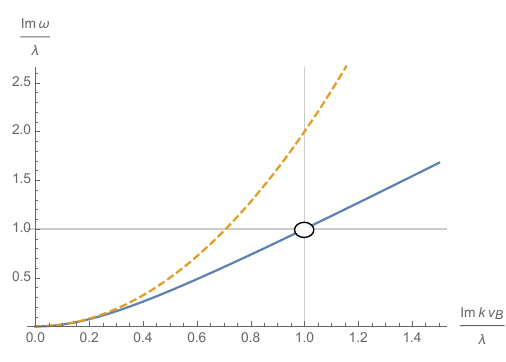
Figure 8 . The hydrodynamic origin of chaos predicts \pole-skipping" in the energy-energy correla- tion function: following the line of poles which starts at small !; k as the energy di(cid:11)usion pole along pure imaginary k to a speci(cid:12)c value of k = i(cid:21)=v B for which the pole would be at ! = i(cid:21) , one (cid:12)nds the pole is not there! In the (cid:12)gure the solid line denotes the line of poles, and the open dot indicates that at that particular point the pole is skipped. The dashed line is the curve ! = coincides with the pole line for small !; k